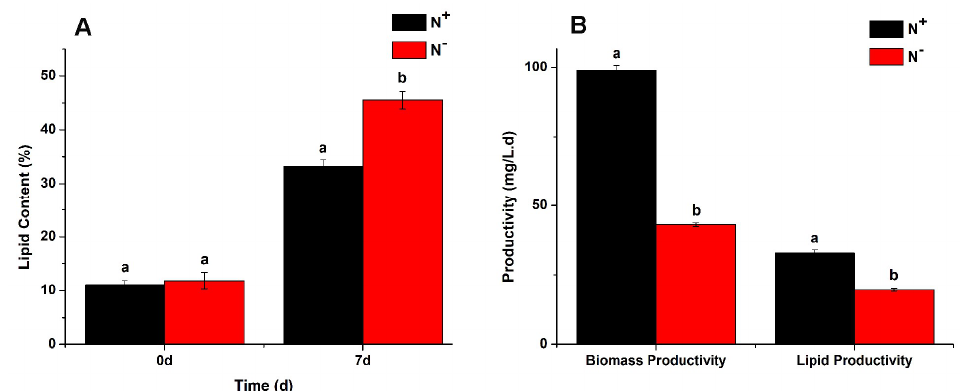
Figure 7. ( A ), Comparison of total lipid contents of Parachlorella kessleri TY02 under N + and N − culture media on the 0 day and 7th day, respectively. ( B ), Comparison of biomass productivity and lipid productivity of P. kessleri TY02 under N + and N − culture media on the 7th day. Data are shown as mean ± SE. n = 3. “aa” indicate non-significant differences ( p > 0.05) and “ab” represent significant differences ( p < 0.05).